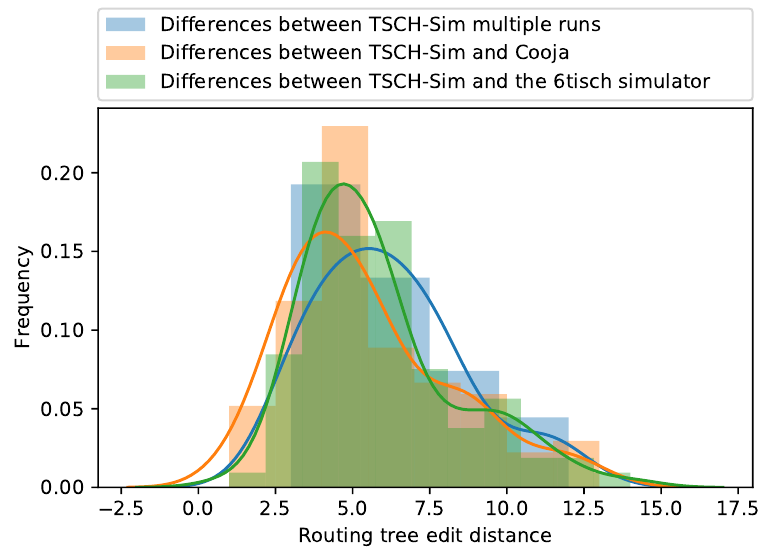
Figure 8. Similarity of the routing tree